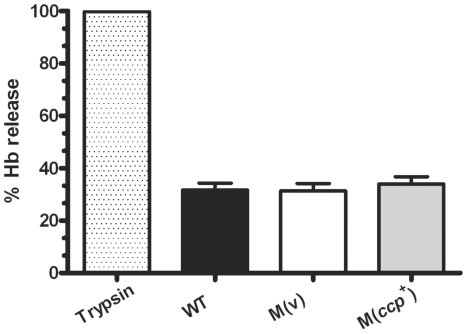
Hydrolysis of hemoglobin.Culture supernatants from mid-exponential phase cultures of the isogenic strains described in Fig. 1 were used to assay for hemoglobin (Hb) hydrolysis. Culture supernatants (n = 4) were mixed with equal volumes of human hemoglobin (1 mg/ml) and incubated for 24 h. Trypsin (0.5%) was used as a positive control. Hemoglobin was precipitated using 3% TCA and the absorbance of the supernatants analysed at 410 nm. The results are shown relative to the amount of hemoglobin hydrolysed by trypsin after 24 h. Error bars indicate S.E.M.